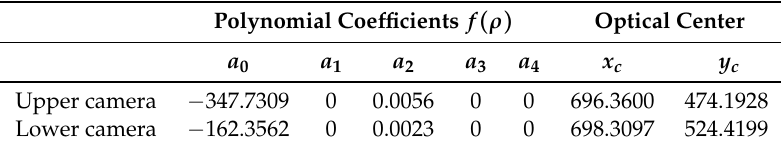
Table 1. Intrinsic parameters of upper and lower